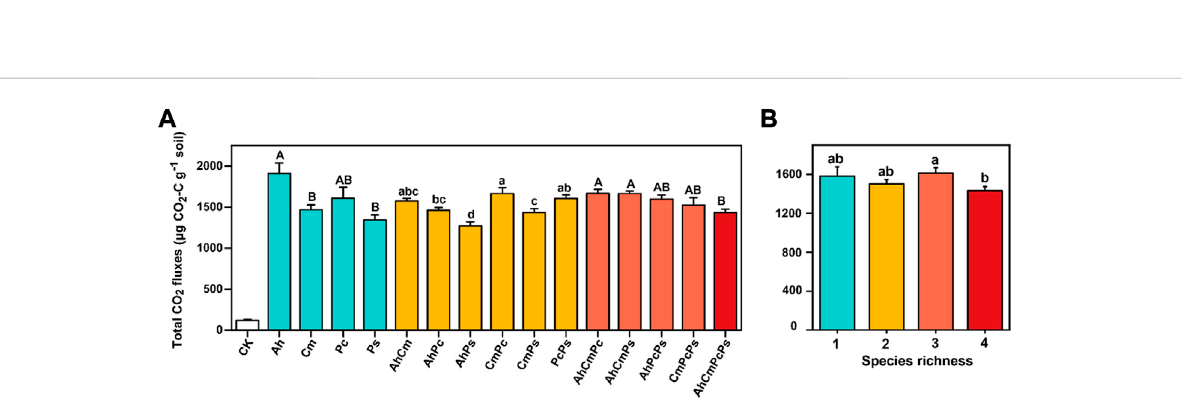
FIGURE 3 Total CO 2 fl uxes in control and litter treatments (A) and cumulative CO 2 fl uxes in different species richness treatments (B) . All means are ±SE, 5 replicates per treatment. Capital letters indicate the difference in single litter difference; Lowercase letters indicate the difference of two litter species mixture; and the difference in CO 2 fl uxes among three and four litter mixtures was also labeled by capital letters (ANOVA followed by LSD test, p <